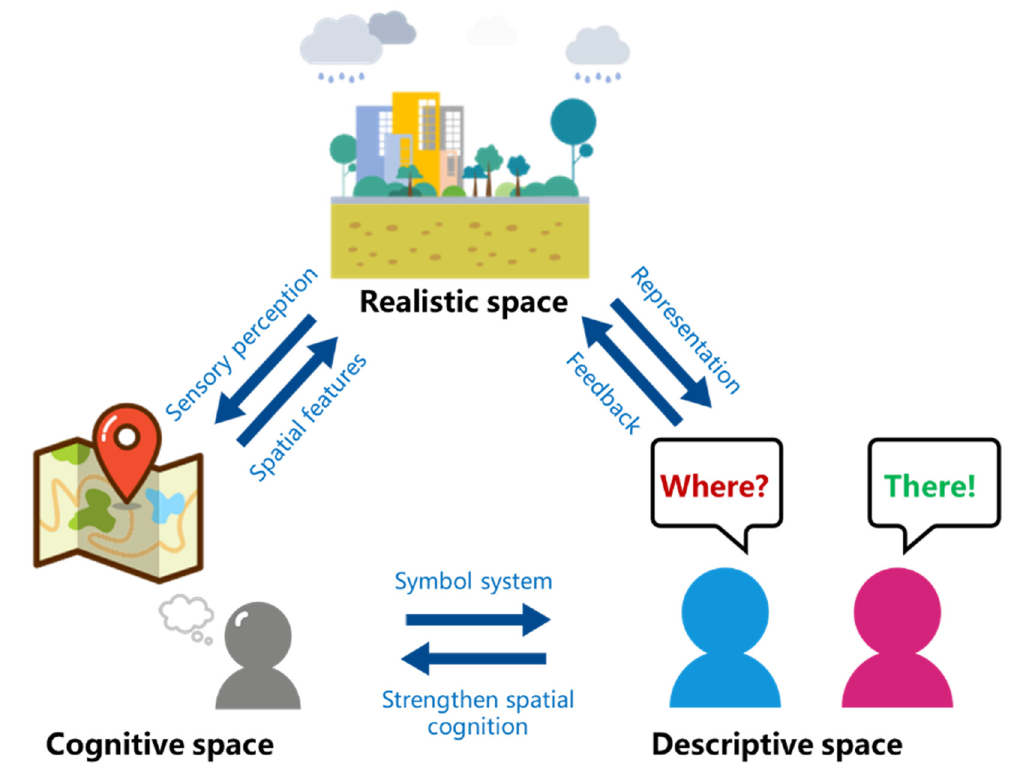
Figure 1. Different stages of spatial cognition.